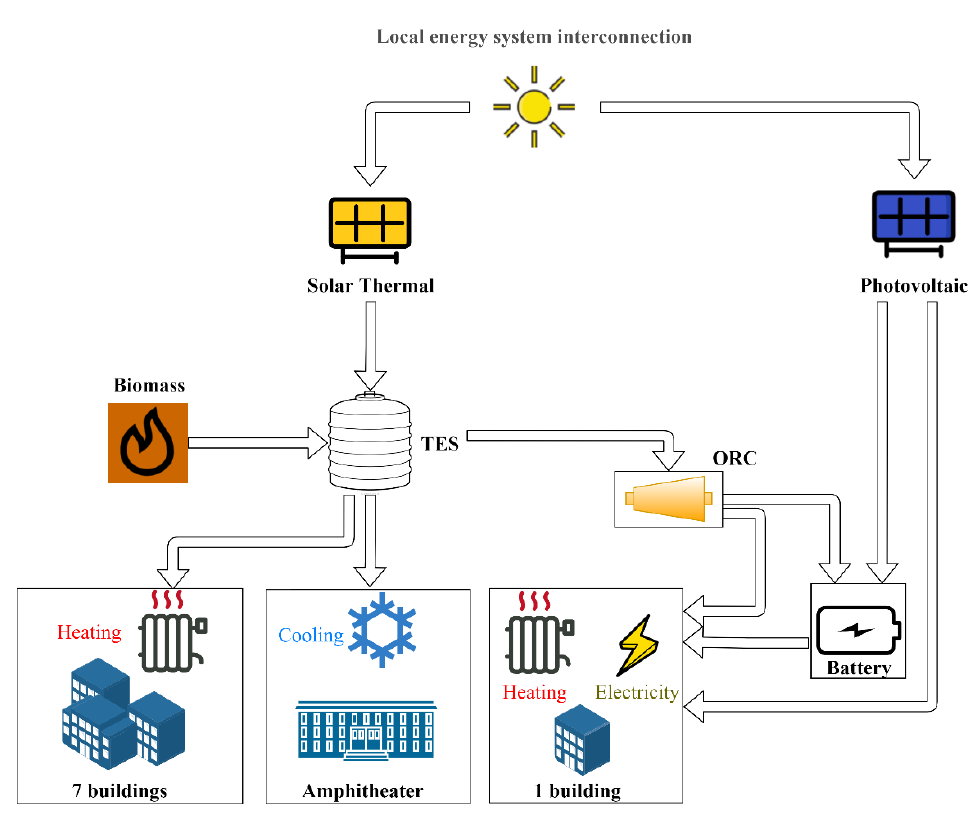
Figure 2. Presentation of the local energy system under study.